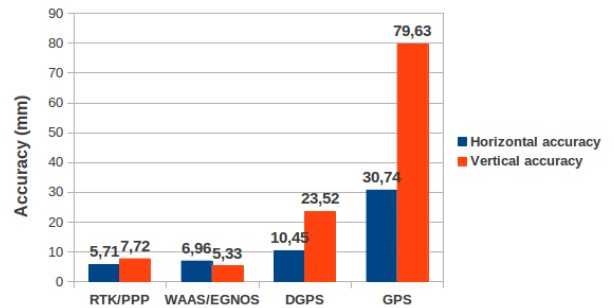
Figure 7: Accuracy of GTPs for different simulated GPS re- ceivers